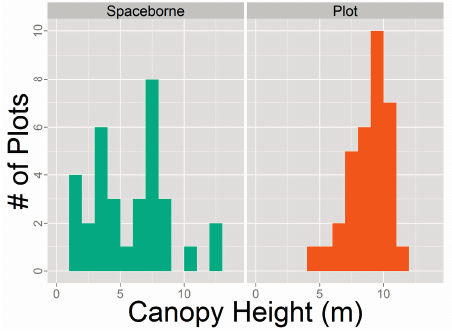
Figure 5. Histograms of the distributions of spaceborne- and plot-derived maximum canopy height at the scale of an individual field